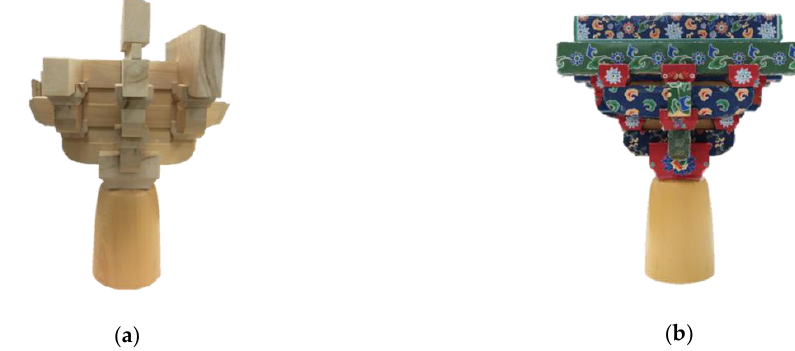
Figure 8. ( a ) Original Dougong models and ( b ) models decorated with colored patterns.